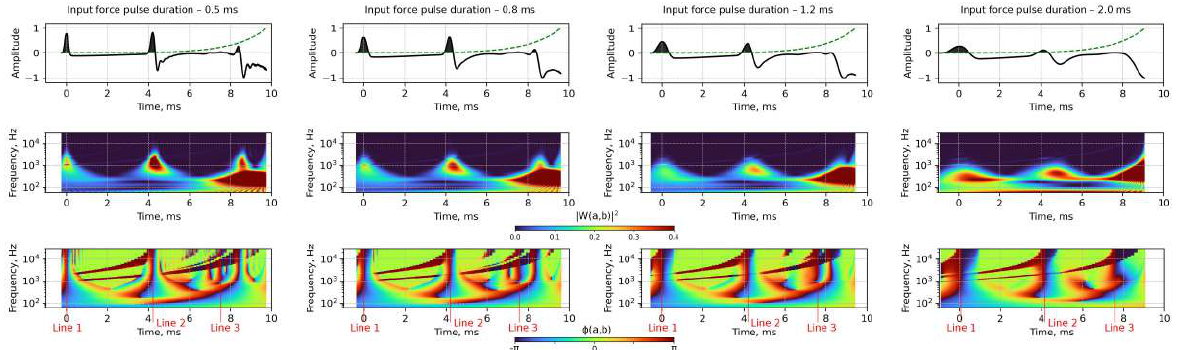
Figure 7. CCWT analysis of the low strain test numerical simulation results for a pile with a splice of 1 mm air gap (Model 4) with input force pulses of 0.5, 0.8, 1.2, and 2 ms duration. 1st row—the simulated signals, 2nd row—the distributions of energy of the wavelet transform coefficients, 3rd row—the distributions of phase angles of the wavelet coefficients. Lines 1, 2, and 3 delineate the phase shift